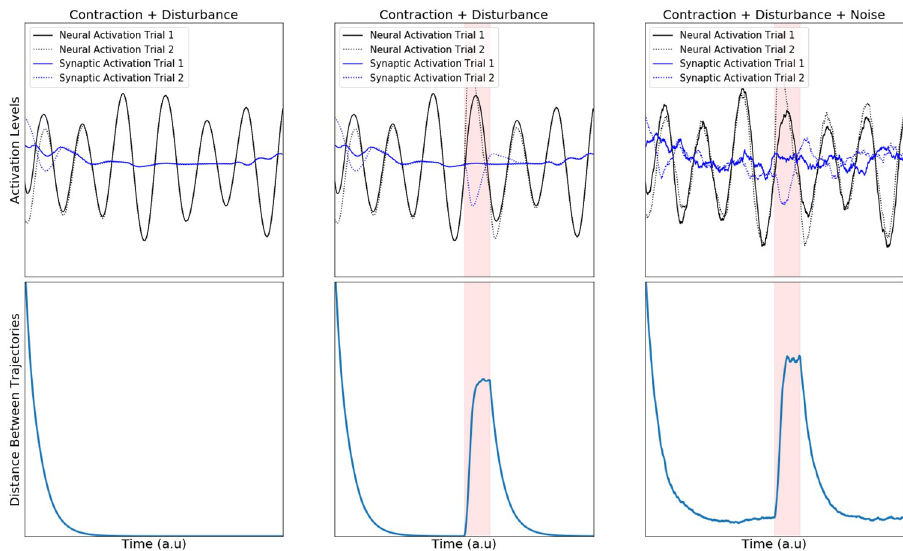
Fig 2. Contracting dynamics of neural and synaptic activity. Euclidean distances between synaptic and neural trajectories demonstrate exponential shrinkage over time. The top row of panels shows the activation of a randomly selected neural unit (black) and synapse (blue) across two simulations (dotted and solid line). The bottom row shows the average Euclidean distance in state space for the whole population across simulations with distinct, randomized starting conditions. Leftmost Panel: Simulations of a contracting system where only starting conditions differ over simulations. Center Panel: the same as in Leftmost but with an additional random pulse perturbation in one of the two simulations indicated by a red background shading. Rightmost Panel: same as in Center Panel but with additional sustained noise, unique to each simulation.